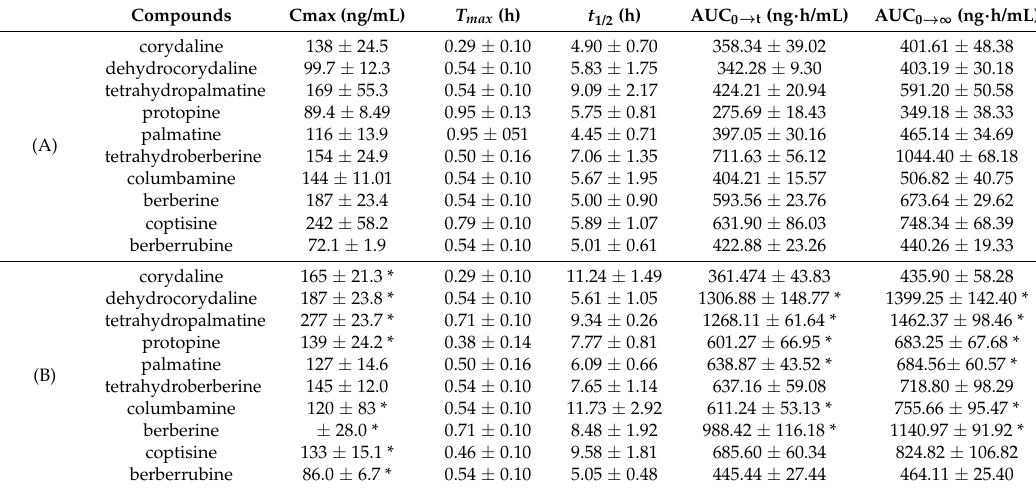
Table 5. Pharmacokinetic parameters of the 10 alkaloids in the beagle dog after oral administration of C. yanhusuo (A) and YHZT (B), respectively. (mean ± SD, n =